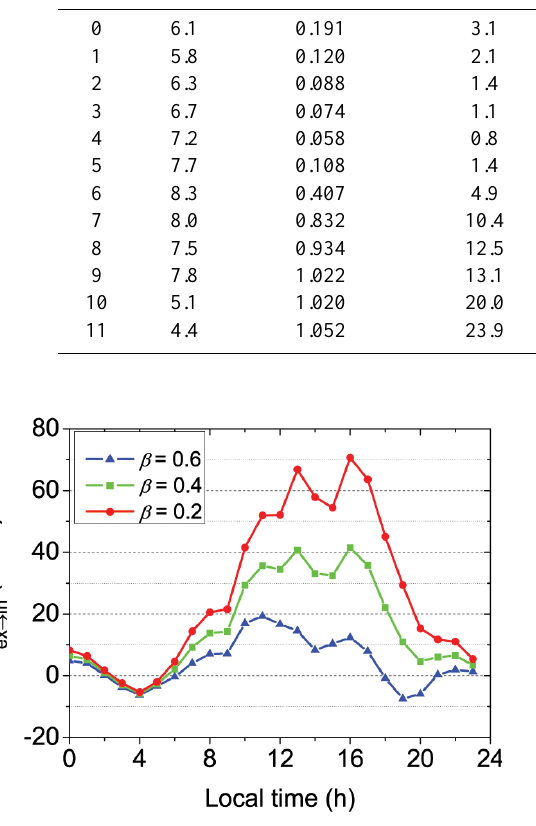
Fig. 6. The actual turnover rate of soot (NVP), k ex → in , assuming different emission factors β (number fraction of internally mixed soot particles to total soot particles in the